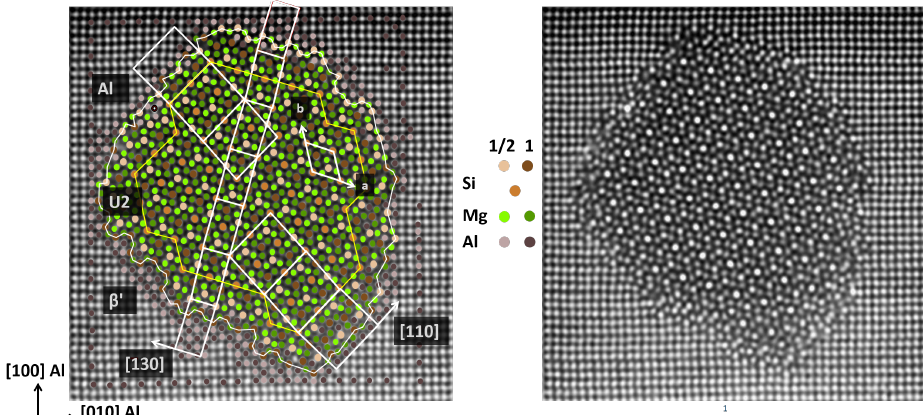
Figure 2. (Colour online). HAADF-STEM image of β (cid:48) . To the left is the image with an atomic overlay identifying the atomic species, and to the right is the original image. The atomic overlay includes the unit cells used to create the models of the Al(130) and Al(110) interfaces. Colouring of the atomic type and height within the aluminium unit cell. The medium-brown Si atom is the column with 2/3 occupancy. The image shows the interface of β (cid:48) with the irregular Al matrix, and it is realized through a thin disordered transition layer. The core of the precipitate is delimited with a yellow line and the interface of the transition layer with a white